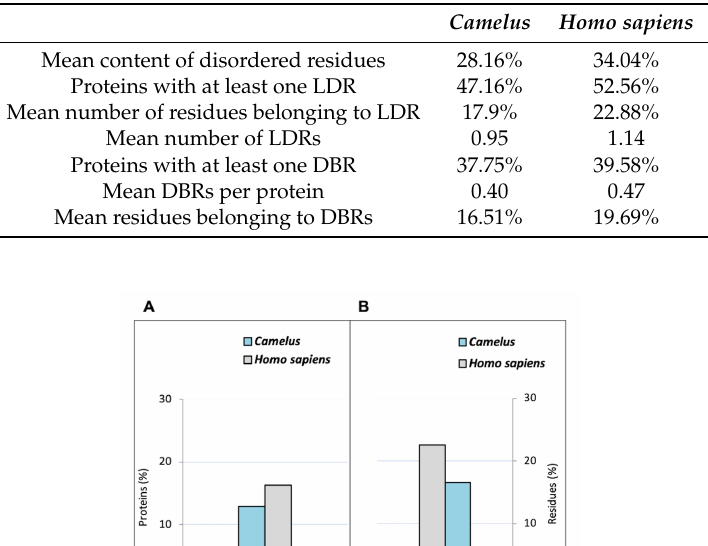
Table 1. Summary of disorder prediction by DISOPRED and disorder binding region prediction by ANCHOR in Camelus and Homo sapiens .